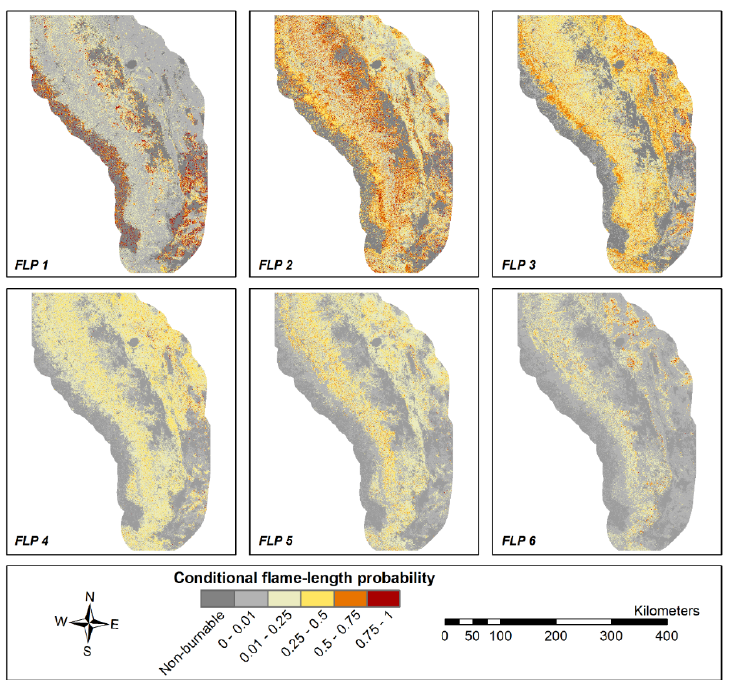
Figure 7. Conditional flame length probabilities ( FLPs ) for each of the six flame length classes for the Southern Sierra Risk Assessment landscape.